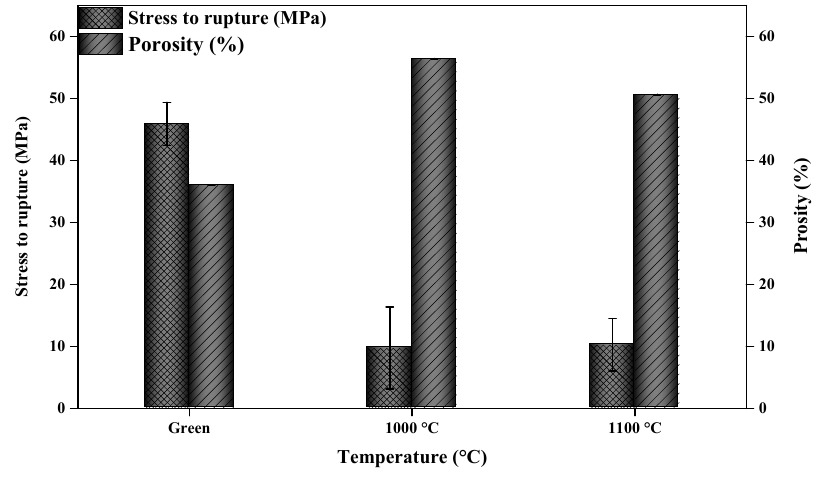
Figure 8. Mechanical properties and apparent porosity of KT2- kaolin mixed with 6 mass% of magnesite.